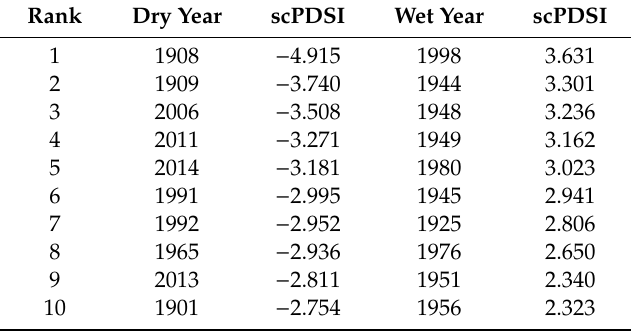
Table 3. The top 10 driest and wettest years of the pMay-cApr scPDSI reconstruction during 1894–2014